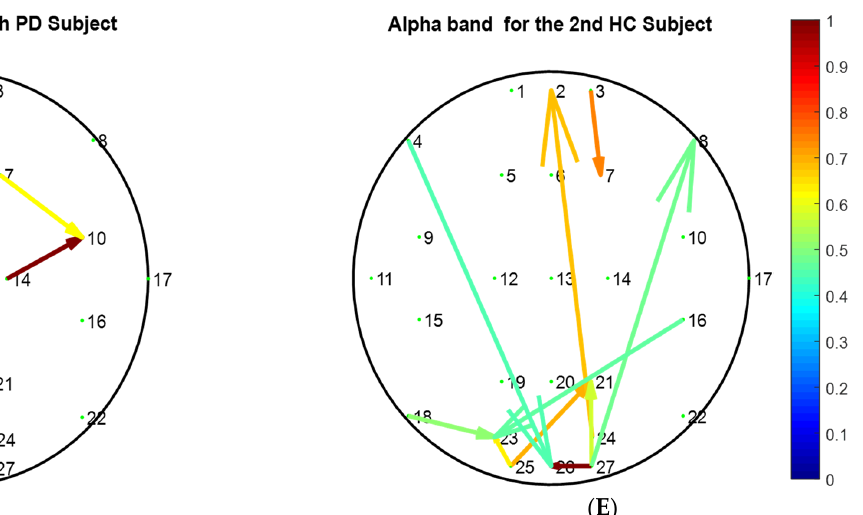
Figure 6. Ten highest normalized directional connections’ values that cause maximum value in feature related to the maximum LASSO coefficient for latent space: ( A ) Right finger tap test; ( B ) Left finger tap test; ( C ) Right tremor test; ( D ) Left tremor test; ( E ) Bradykinesia. Table 7. A related subject, health status (PD/HC), and the band of the DC heat map leading to the maximum value among 64 features for each clinical test.